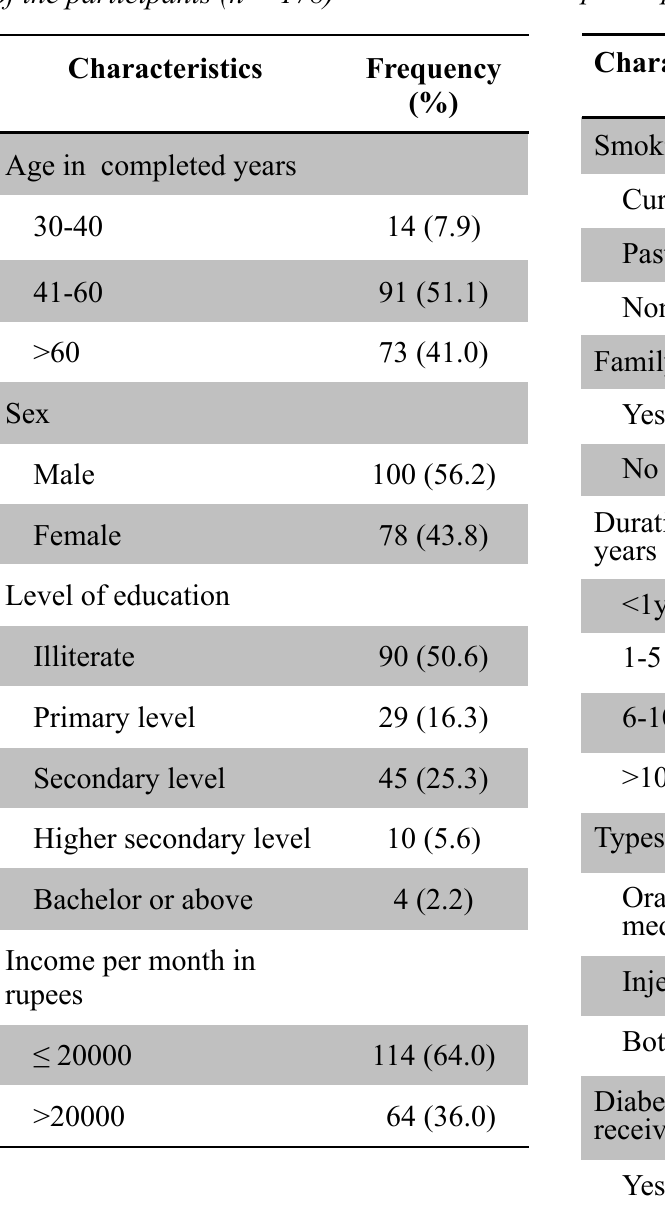
Table 2: Clinical characteristics of the participants (n =